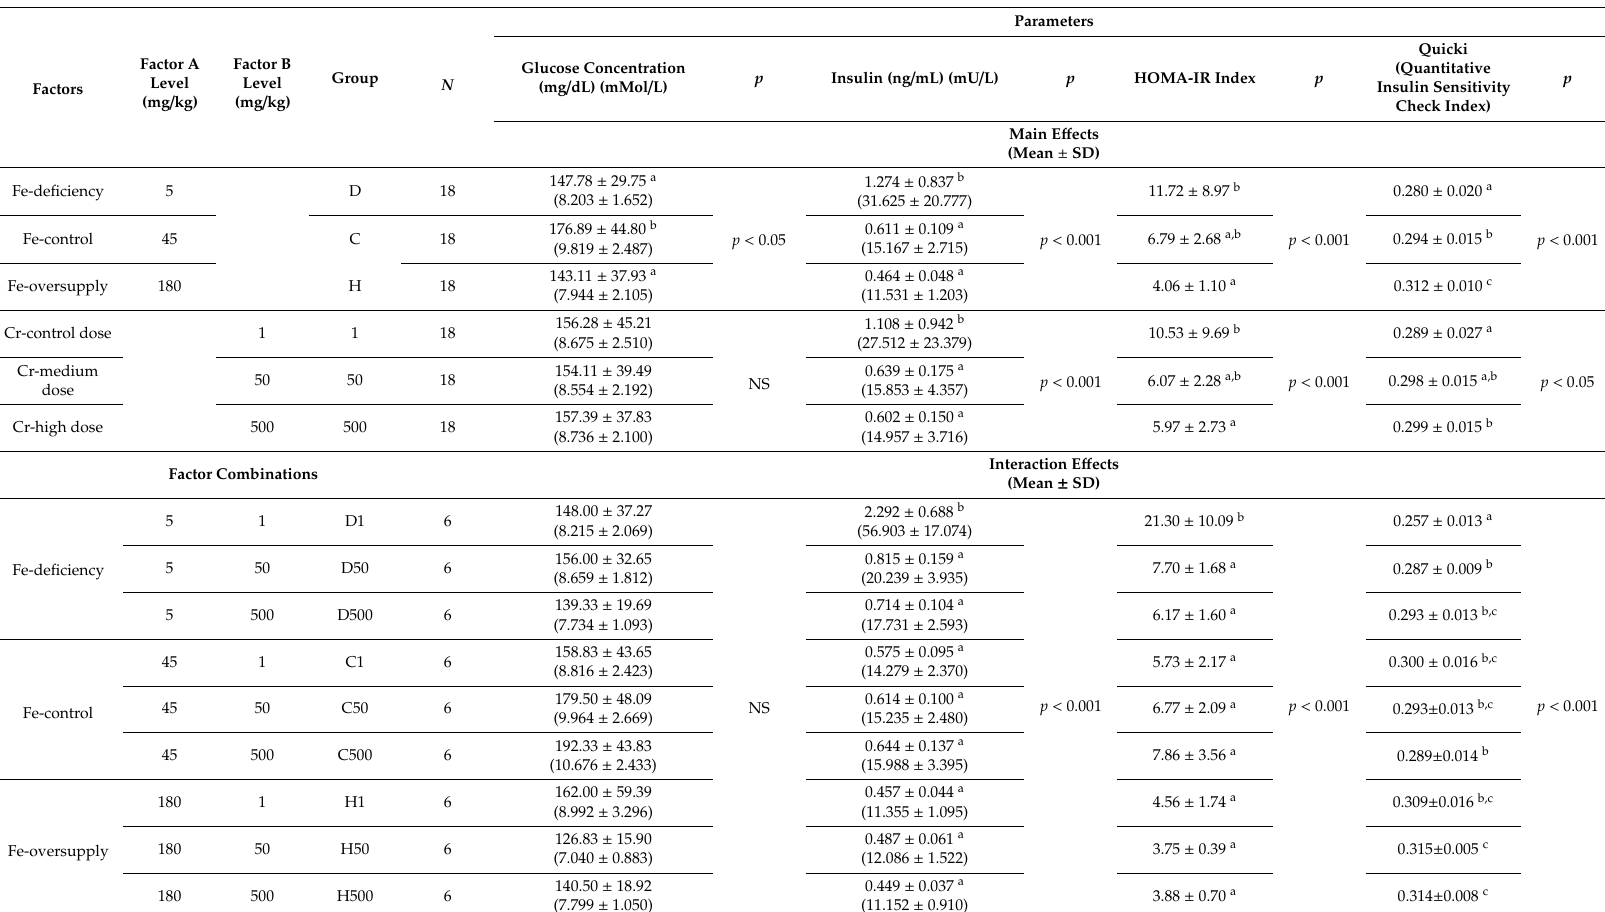
Table 3. The e ff ects of the Fe(III) and Cr(III) levels in the diet on the glucose and insulin concentrations and parameters of insulin resistance in rats.